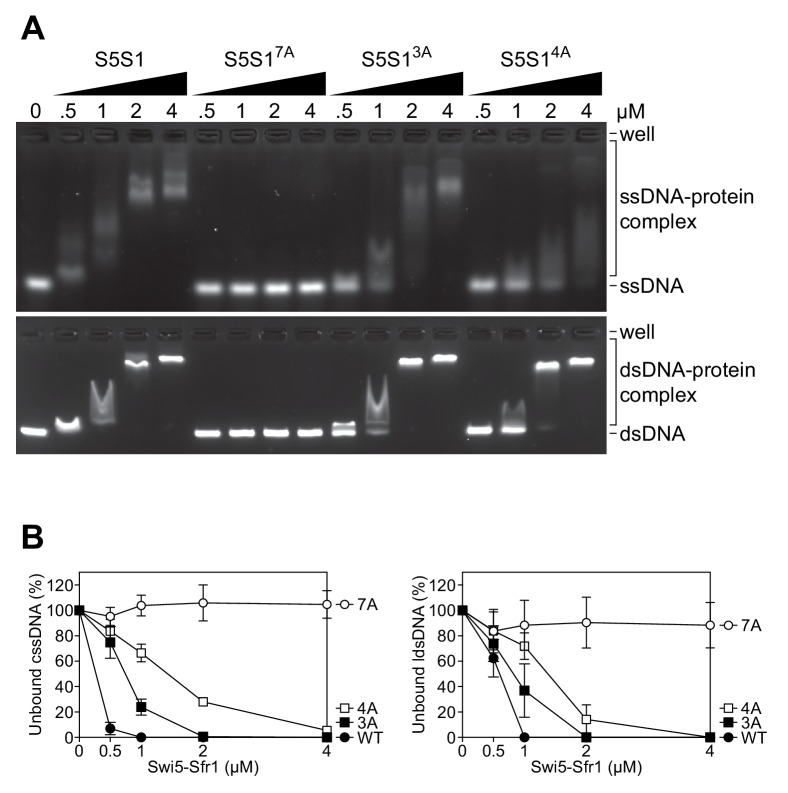
DNA binding is differentially defective in Site 1 and Site 2 mutants.(A) Swi5-Sfr1 (S5S1, wild type or mutants) was incubated with ssDNA (top) or dsDNA (bottom) and protein-DNA complexes were resolved by agarose gel electrophoresis. (B) The amount of unbound ssDNA (left) or dsDNA (right) was quantified and expressed relative to the no protein lane, which was set to 100%. For (B), mean values of three independent experiments ± s.d. are shown.Figure 6—figure supplement 1—source data 1.Unbound DNA (%) for data in Figure 6—figure supplement 1B.